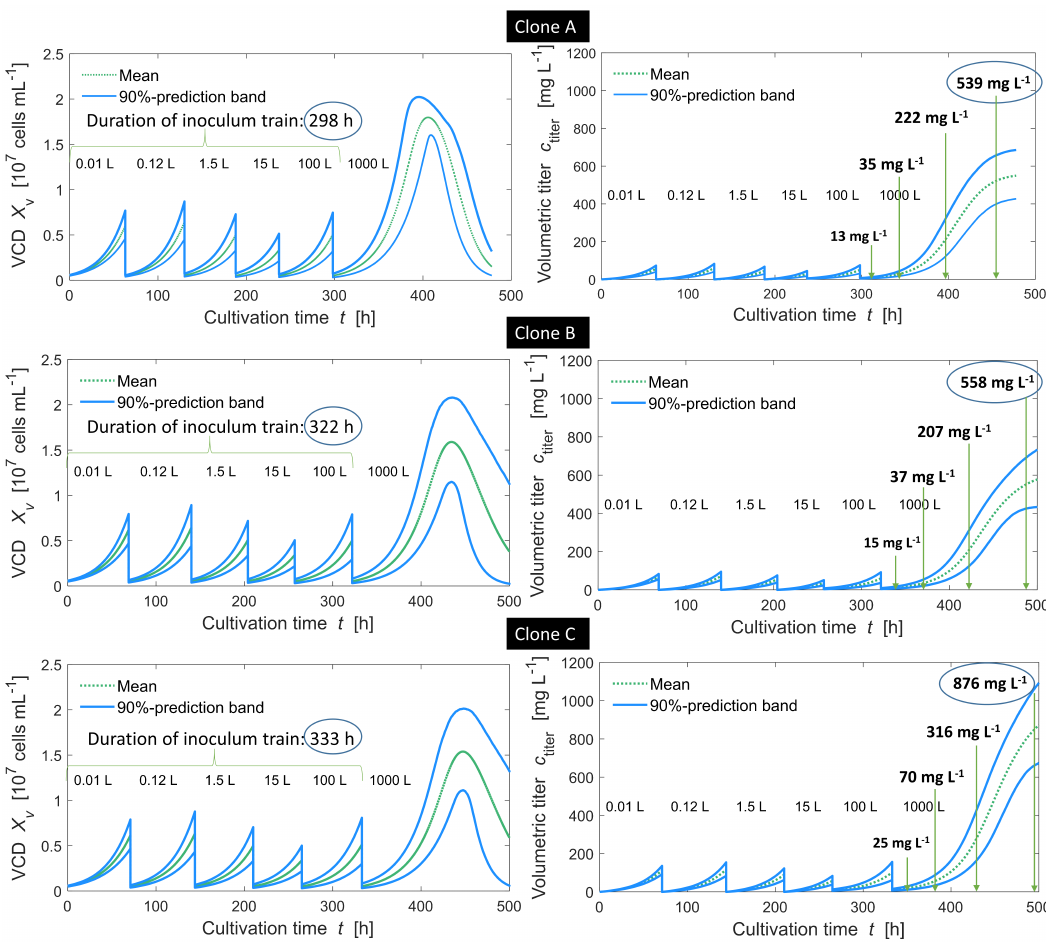
Figure 6. Simulated viable cell density (VCD) and volumetric titer over inoculum train cultures (5 scales) and production scale (1000 L) for clones A (above), B (middle) and C (below). The maximum growth rate of clone B was 7.6% lower than that of clone A, and the maximum cell-specific production rate of clone B was 10.5% higher than that of clone A. The maximum growth rate of clone C was 10.5% lower than that of clone A and the maximum cell-specific production rate of clone C was 74% higher than that of clone